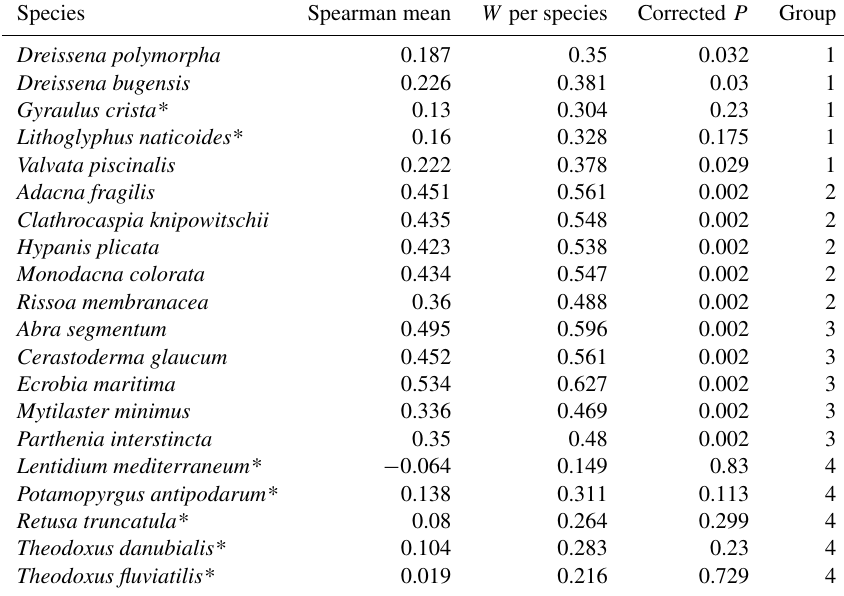
Table 2. Results of the a posteriori test of the contributions of individual species to the overall concordance of the four groups identified by k -means clustering at k = 4. Provided are the mean Spearman correlations between a species and all other species in the respective group, its contribution to the overall concordance statistic W for that group, the permutational probability corrected using Holm’s method and the group it is associated with. Species belonging to the non-concordant group and those not significantly associated ( P >0.05) are marked with an asterisk. Note that, except for the outlier Rissoa membranacea , groups 1–3 correlate well with the three defined salinity